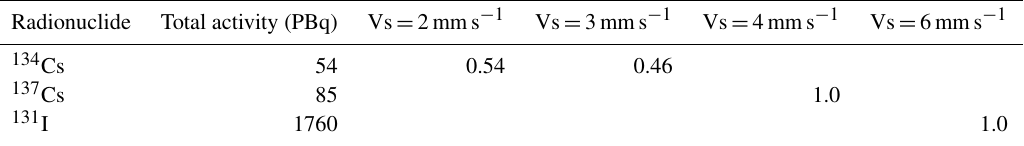
Table 5. Total radioactivity emitted in the atmosphere during the Chernobyl accident in the period 24 April–10 May 1986, for caesium and iodine isotopes, and their best fit fractions in the considered settling velocity